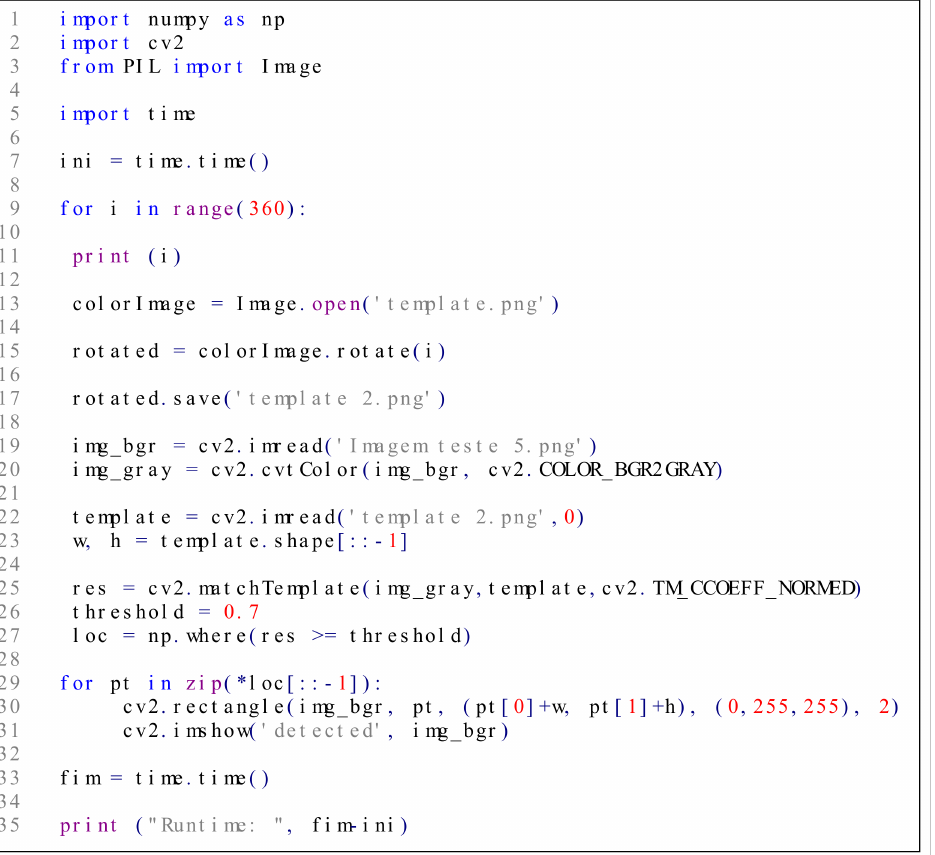
Figure 7. Triggering mechanism implementation in Python.